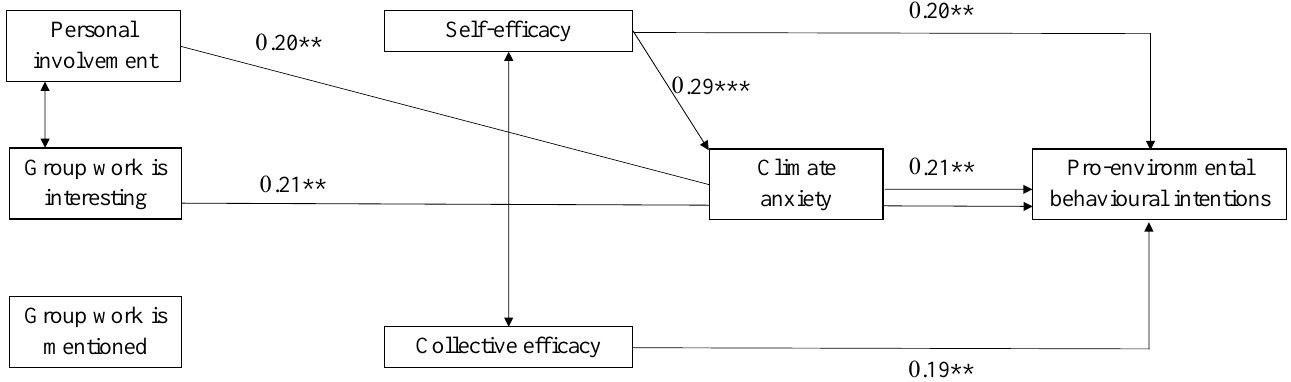
Figure 2. Results of the path model. Only significant (and standardized) estimates are presented. The effects of control variables are not included in the present figure. Note that there is a direct relationship between ‘group work cited as interesting’ and ‘behavioral intentions (and no indirect link through ‘climate anxiety’) . *** p < 0.001; ** p < 0.01 .